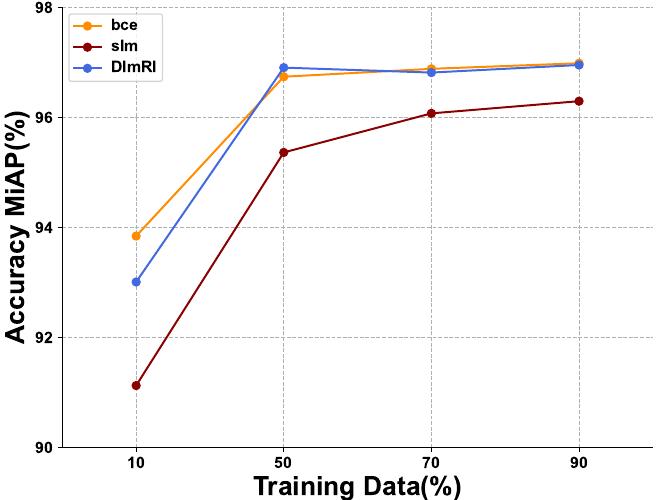
Figure 3. The figure shows the MiAP score (%) of three different loss methods on VOC2007 with full labels. The orange line indicates the accuracy rate using BCE with Logits Loss (bce); the red line indicates the accuracy rate using MultiLabel SoftMargin Loss (slm); and the blue line indicates the accuracy rate using our